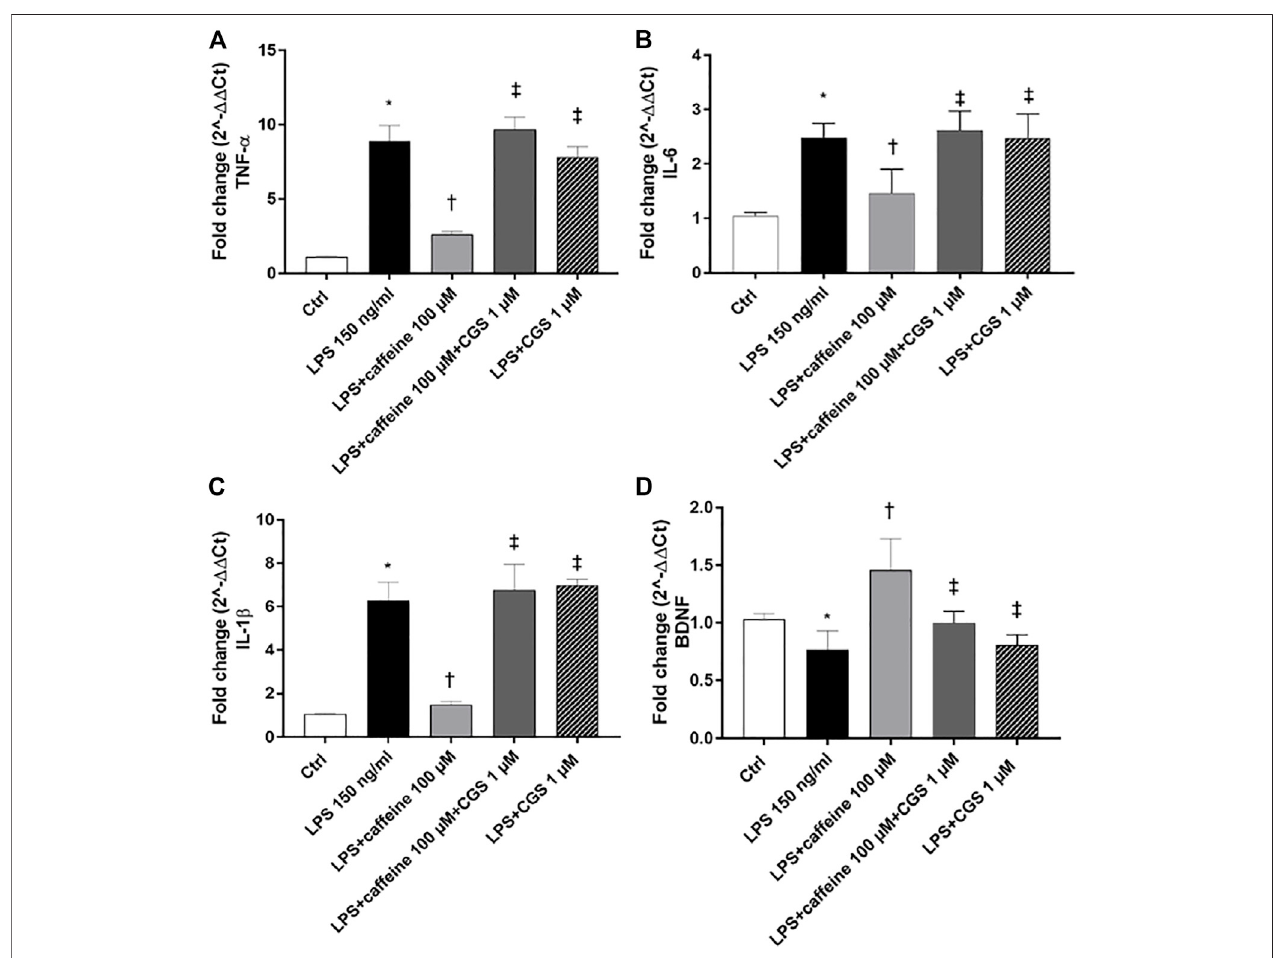
FIGURE 3 | The selective A 2A agonist CGS 21680 counteracts the effects of caffeine. Cells were pretreated with caffeine (100 µM) and/or CGS (1 µM) for 24 h andthenco-treatedwithLPS(150 ng/ml)for2 h.ThetreatmentwithCGS(LPS+CGS;LPS+caffeine+CGS)didnotcounteractLPS-mediatedeffectsasregardas in fl ammatory cytokines (A – C) or BDNF (D) . Contrarily, pretreatment with caffeine(LPS + caffeine) reduced in fl ammatory cytokinesmRNA expression and increased BDNF mRNA levels. Values are reported as mean ± SD; n (cid:1) 4. Data were analyzed by one-way ANOVA and the Tukey post hoc test for